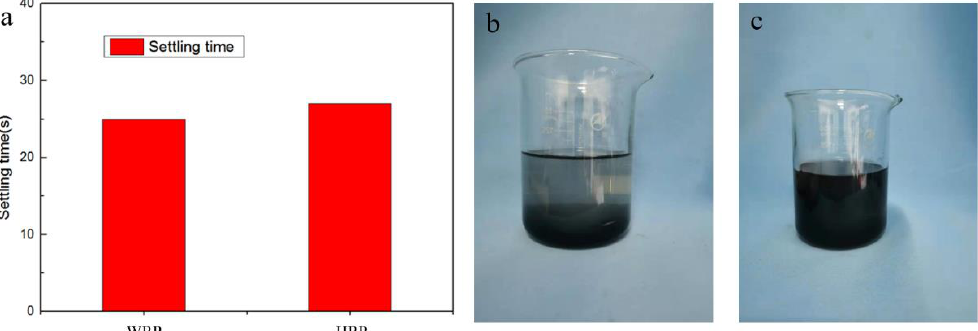
Figure 6. The setting time of WRP and HRP (a ) and the photo of HRP solution after 4 h with suspension agent ( b ) and without ( c ).